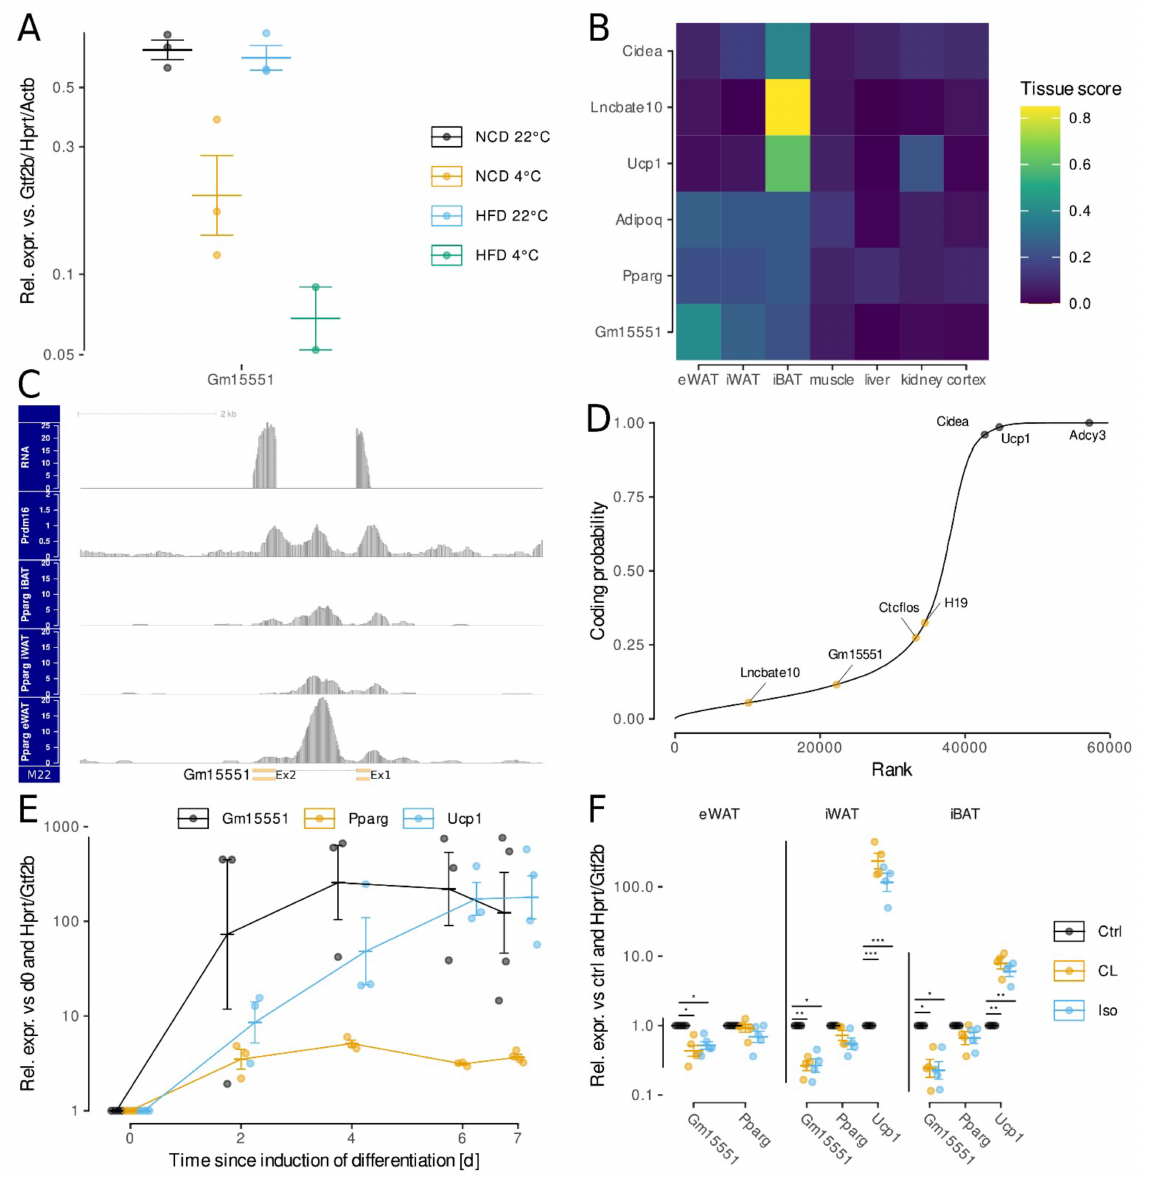
Figure 2. Gm15551 is an adipose tissue-specific, diet- and temperature-regulated lncRNA. ( A ) Expression of Gm15551 in iBAT from cold treated and/or HFD fed mice. ( B ) Expression pro- file of Gm15551, the common adipocyte marker genes Pparg and Adipoq as well as the iBAT specific lncRNA Lncbate10 and the brown adipocyte marker genes Ucp1 and Cidea in seven metabolically active tissues. ( C ) Genomic locus of Gm15551 showing the RNA expression as well as binding sites of PRDM16 in iBAT (GEO: GSE63965) and PPARG in eWAT, iWAT and iBAT (GEO: GSE41481) as well as the annotated transcripts in GENCODE M22. ( D ) Ranked coding probability of all genes expressed in the dataset as calculated by CPAT. Indicated are Gm15551 , the coding genes Ucp1 , Adcy3 and Cidea as well as the lncRNAs Ctcflos , H19 and LncBate10 . ( E , F ) Expression profiles of Gm15551 , the common adipocyte marker gene Pparg and the brown adipocyte marker gene Ucp1 during the differentiation of PIBA cells ( E ) and in fully differentiated primary adipocytes ( F ) stimulated for 24 h with the non-selective β -adrenergic agonist isoproterenol or the β 3 -specific agonist CL316243 (paired t -test, n = 4–5). * means p < 0.05, ** means p < 0.01, *** mean p <